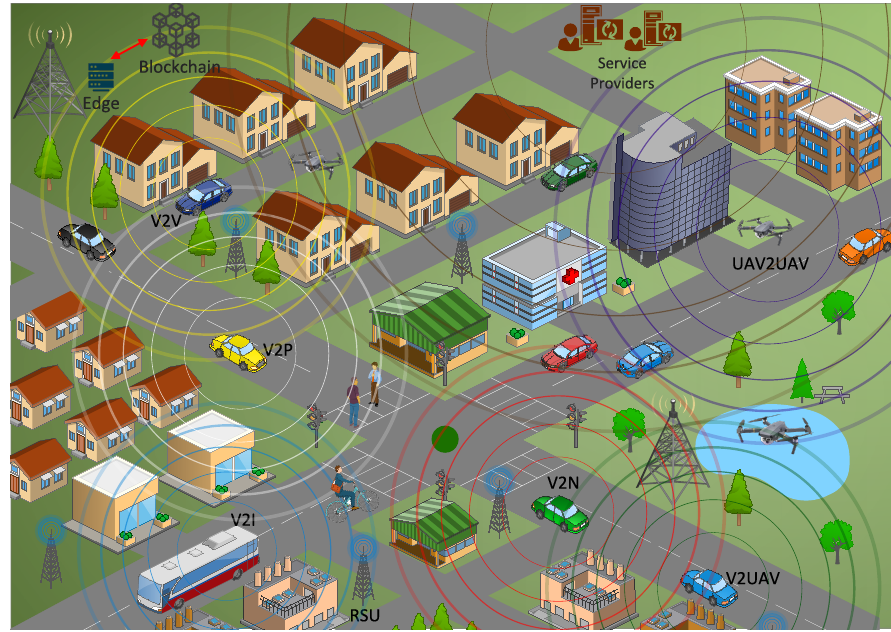
Figure 1. MEC-enabled Internet of Flying Things for Smart